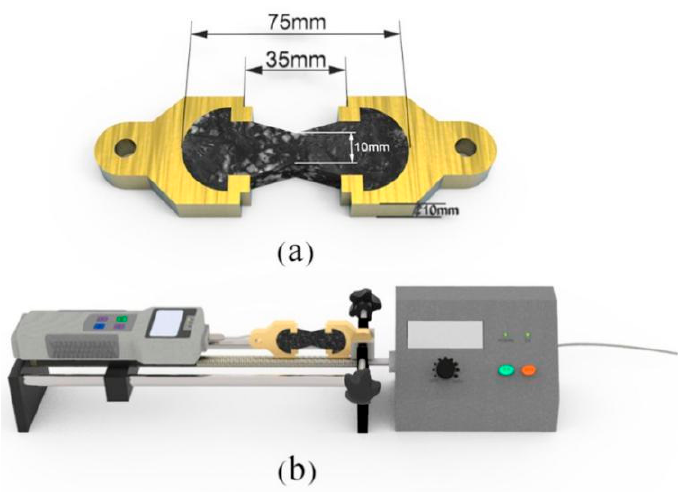
Figure 2. Illustration of the tensile property testing mold, ( a ) testing mold and ( b ) machine model.